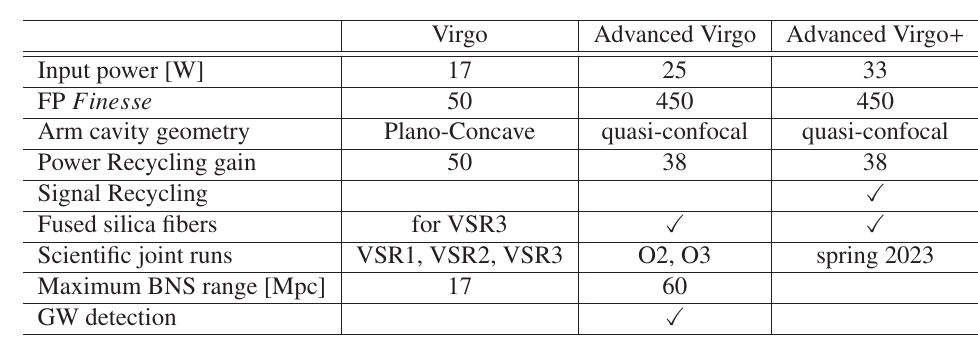
Figure 1. Schematic drawing of the Virgo detector in which the main optical components are shown as: the Fabry-Perot cavities (FP cavities), 3km long orthogonal arms, the Power Recycling mirror (PR), the Signal recycling mirror (SR), the Beam Splitter mirror (BS) which splits the incoming beam generated by the laser source in the two cavities and defines the interference condition at the detection port. Moreover two additional cavities are implemented to clean and stabilize the input and output beam, the Input Mode Cleaner (IMC) and the Output Mode Cleaner (OMC) respectively.